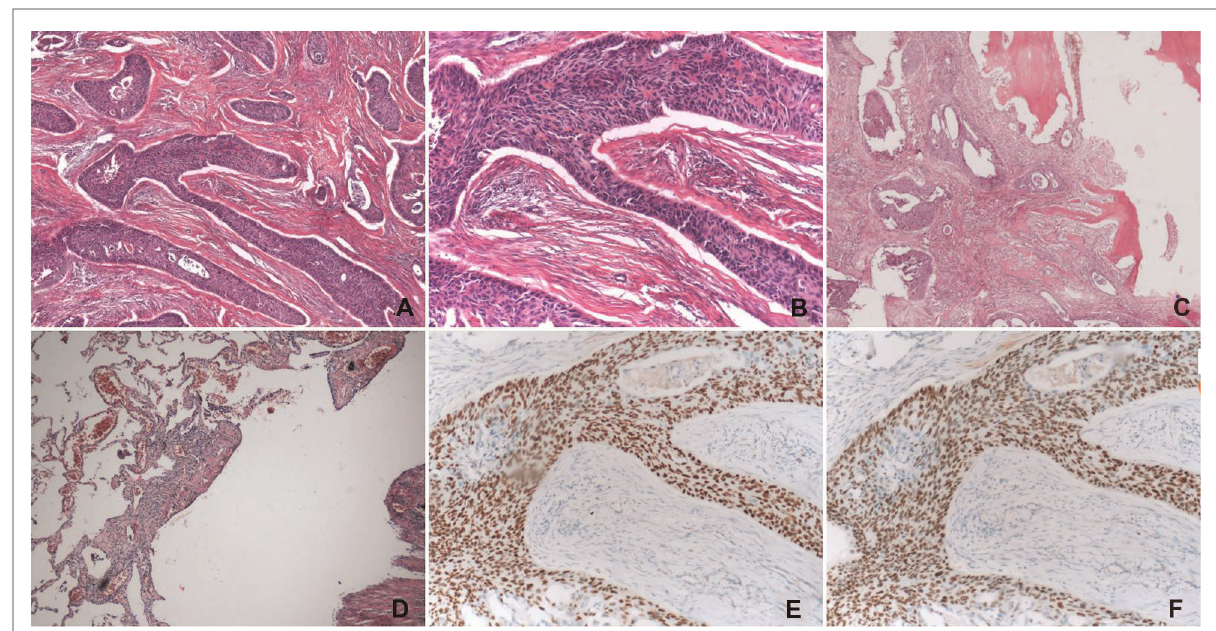
FIGURE 2 ( A ) The neoplastic cells were arranged in the form of nests with different sizes and showed various intercellular bridges (H&E stain, magni fi cation ×40). ( B ) The cells were round or ovoid, with abundant cytoplasm, large nuclei, apparent nucleoli, and intracellular keratinization in focal areas (H&E stain, magni fi cation ×100). ( C ) Squamous cell carcinoma invading the adjacent ribs (H&E stain, magni fi cation ×40). ( D ) Pulmonary bullae with chronic in fl ammation (H&E stain, magni fi cation ×40). ( E,F ) Immunohistochemical staining of neoplastic cells was performed with the use of antisera against p40 and p63, respectively, which showed evident nuclear positivity for both ( E ) p40 and ( F )